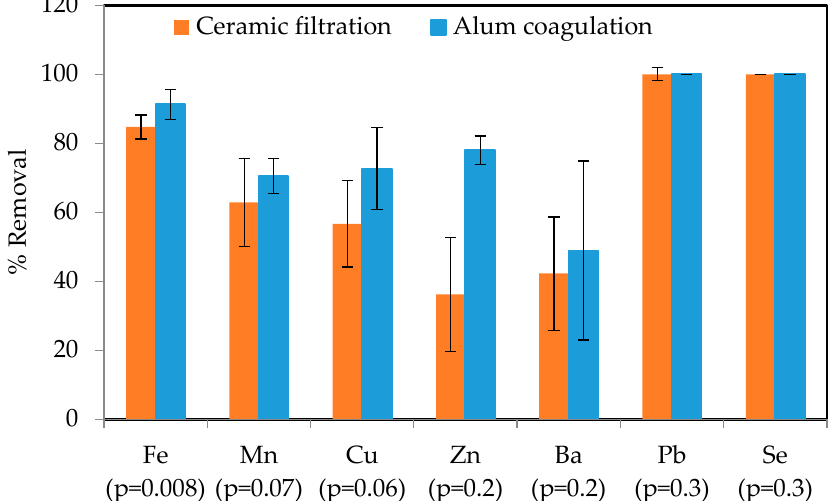
Figure 5. Removal % of heavy metals by ceramic filtration and alum coagulation. Error bars show the standard deviation of triplicate samples. P values show the statistical significance of the two processes derived from a paired t-test.